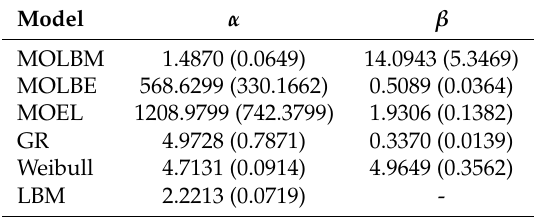
Table 9. Estimates and standard errors (in parentheses) of the parameters for Data set 2.